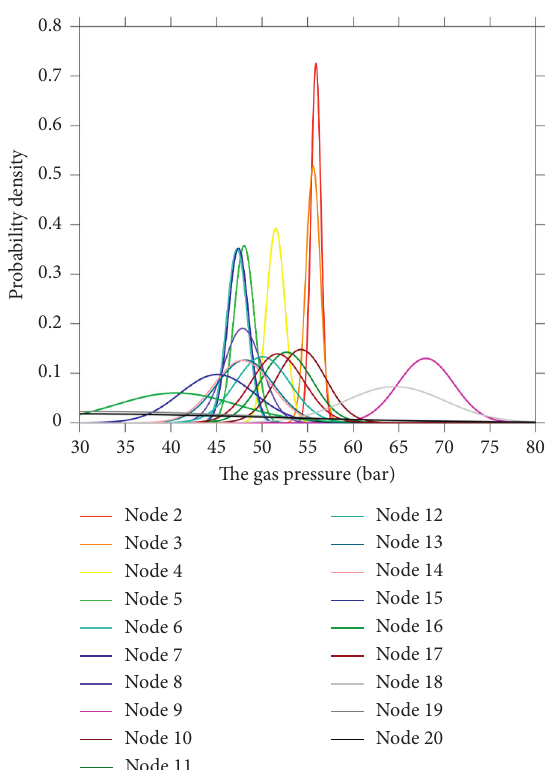
Figure 7: Probability distribution of the eigenvalue.